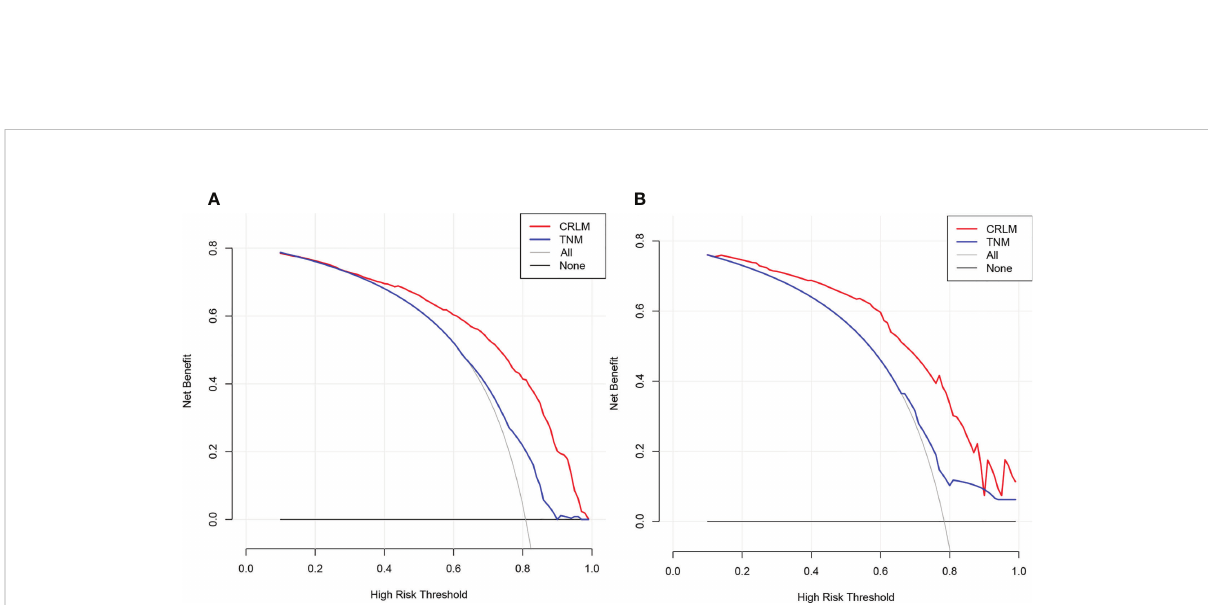
FIGURE 5 Decision curve analysis of CRLM nomogram in the training (A) and validation (B) cohorts. Horizontal lines indicate that no cases will experience the event. Gray lines indicate that all cases will experience the event. Red and blue lines represent the net bene fi ts across threshold probabilities according to the CRLM nomogram and TNM classi fi cation, respectively. CRLM, colorectal cancer with liver